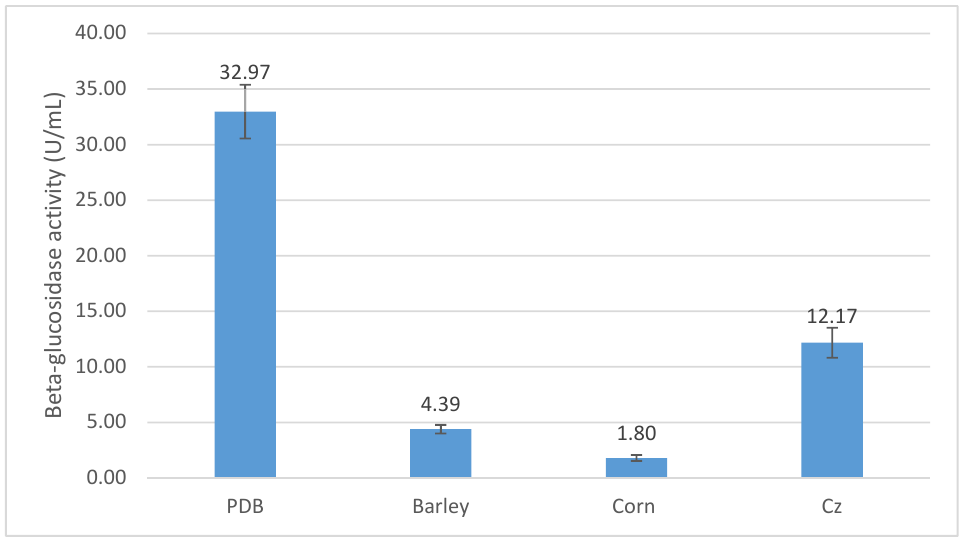
Figure 4. E ff ect of di ff erent carbon sources on β -glucosidase activity of P. citrinum . Figure 4. Effect of different carbon sources on β -glucosidase activity of P. citrinum .